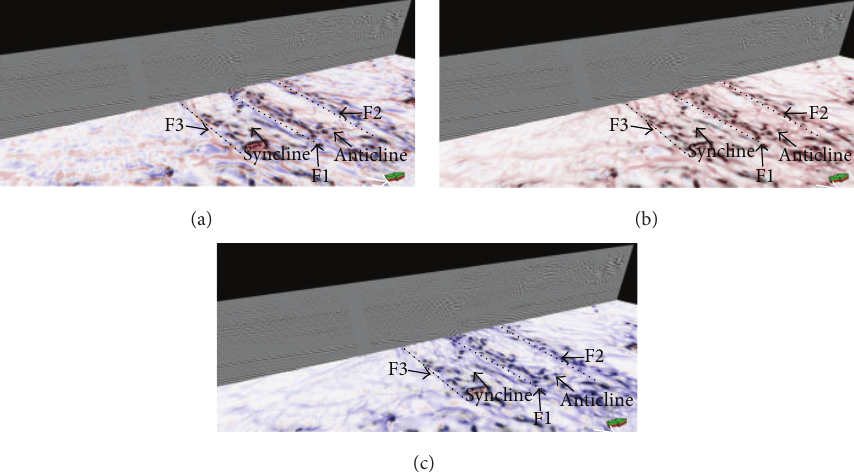
Figure 13: Interpreted faults (F1, F2, and F3) and folds delineated by corendering coherence (50% opacity) with (a) maximum curvature ) , (b) most-positive curvature (𝐾 (𝐾 max